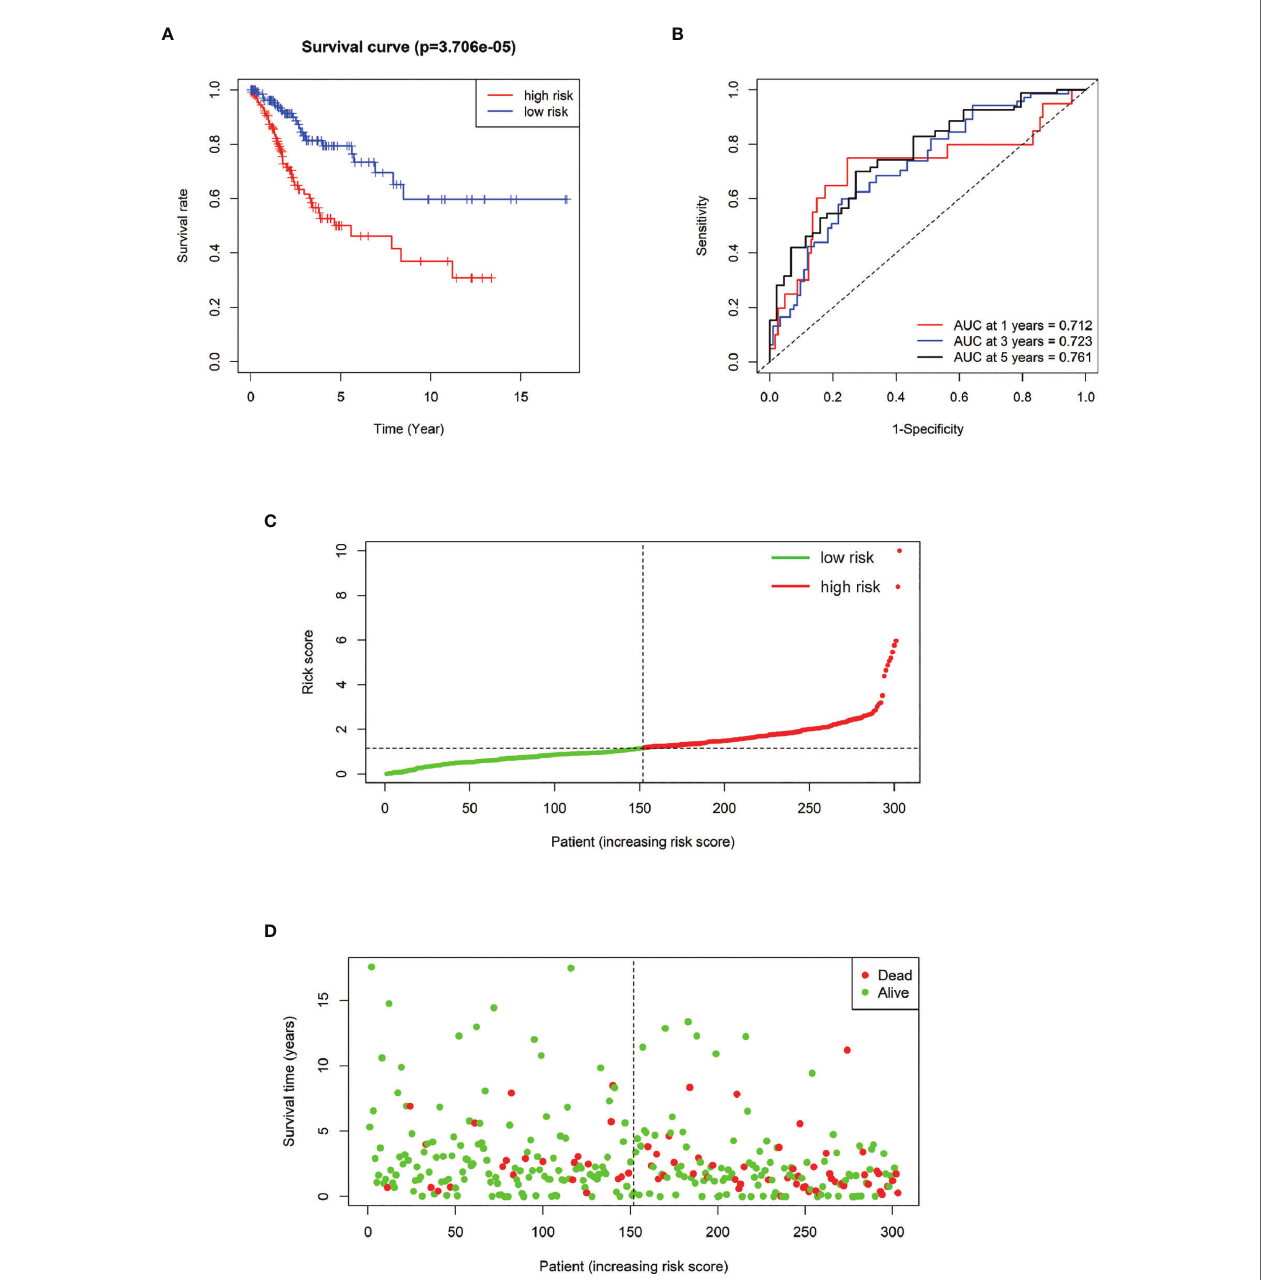
FIGURE 4 | (A) Kaplan – Meier survival curve of overall survival between the high ‐ risk group and low ‐ risk group. (B) The 1-, 3-, 5 ‐ year survival time ‐ dependent ROC curve. (C, D) The distributions of the risk score and survival status for each